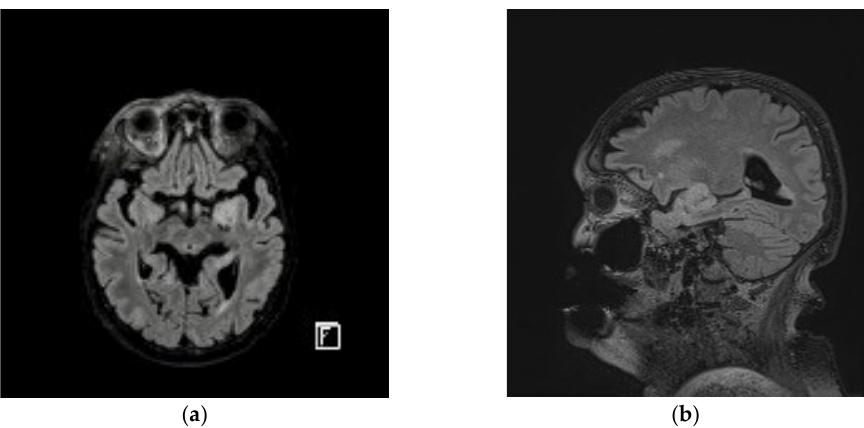
Figure 8. ( a ) Axial MRI image of a large heterogeneous mass in the left frontal lobe. ( b ) Lateral MRI image of a large heterogeneous mass in the left frontal lobe.